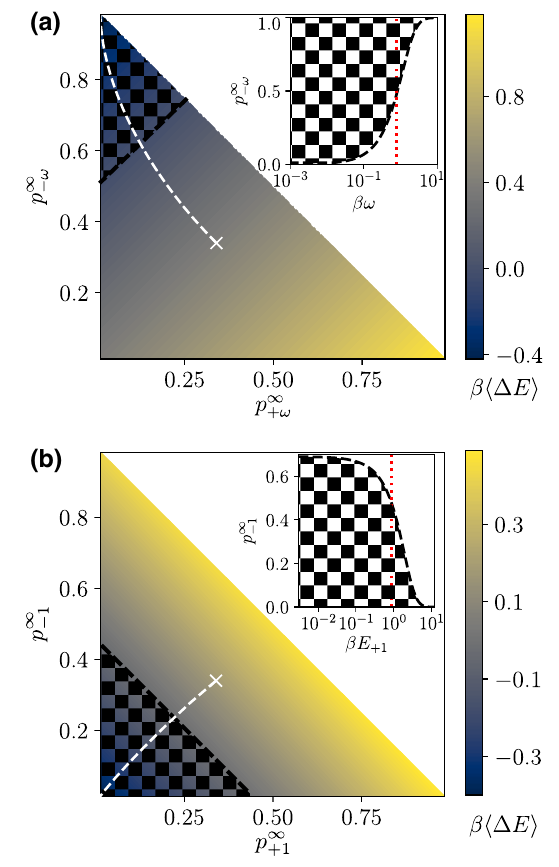
FIG. 5. Values of β (cid:3) (cid:3) E (cid:2) as a function of the asymptotic state populations for H = H MW (a) and for H = H NV (b). In these plots, each point represents a different asymptotic state of the generic quantum dissipative map (cid:13) d . The white cross represents a completely mixed asymptotic state for a 3LS, corresponding to the only case in which the map is unital. In addition, the subspace of thermalizing dynamics is indicated by the dashed white line, denoting that the asymptotic state is a thermal state with inverse temperature β ∞ . Instead, the black line corresponds to the subspace of states for which β (cid:3) (cid:3) E (cid:2) = 0. The checkered area corresponds to the cases where the energy of the system is reduced, β (cid:3) (cid:3) E (cid:2) < 0 (i.e., the asymptotic states for which it is possible to extract energy from the system). Note that the inverse temperature of the initial state is fixed for each plot: (a) β = 0.891 / E β = 0.8 / E + ω and (b) + 1 . The insets show that by = 0 (b)], we are able to show the fixing p ∞ + ω = 0 (a) [or p ∞ + 1 region where β (cid:3) (cid:3) E (cid:2) < 0 as a function of both the asymptotic state populations and the initial inverse temperature β . Notice that β ( x axis) is scaled with the highest Hamiltonian eigenvalue. The dashed red line corresponds to the value of β in